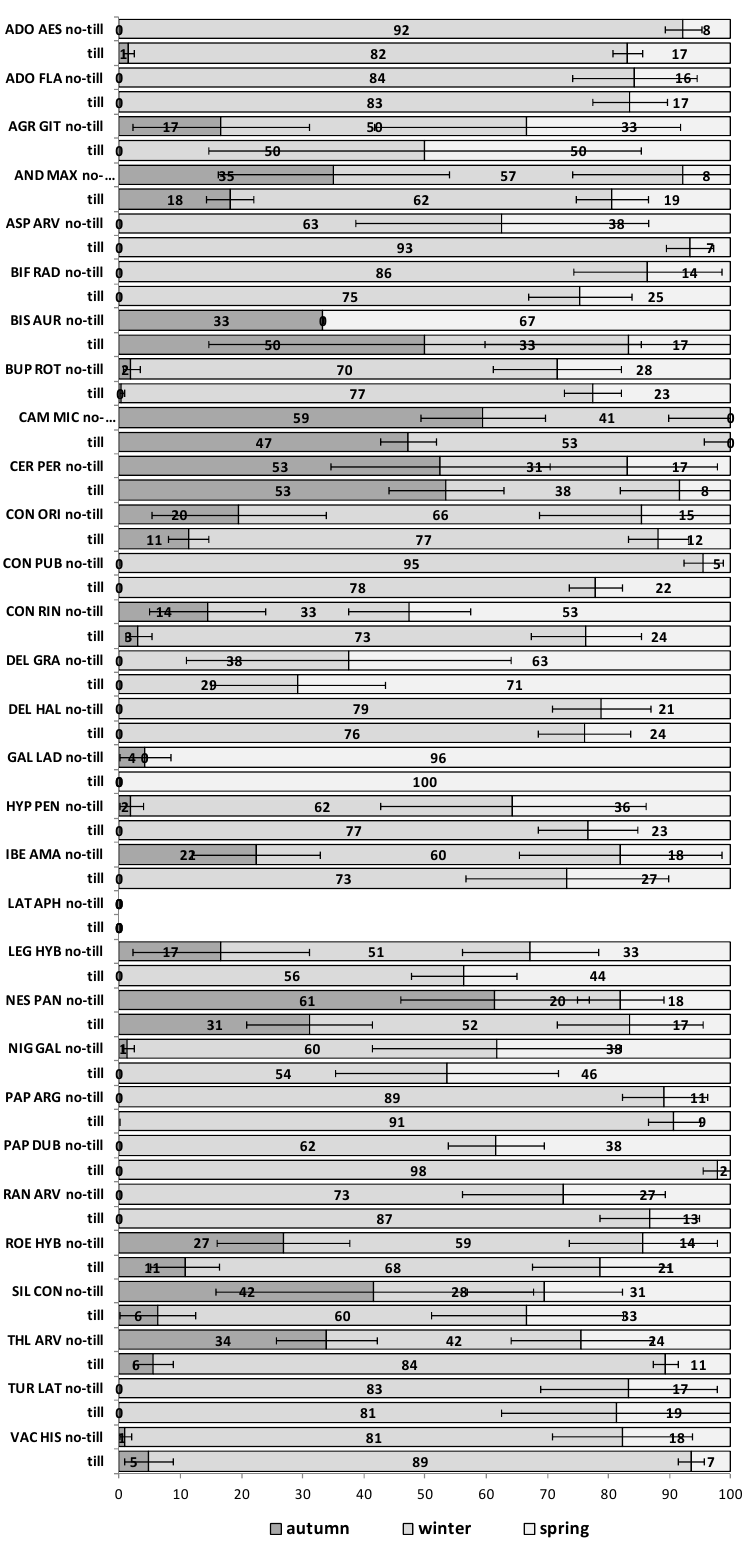
Figure A2. Relative Emergence patterns of 30 RAPs in autumn, winter, and spring during the second season (2013 / 2014) for seeds sown in 2012 (S1) in an arable field trial in Spain. Bars represent standard error. Two burial conditions are shown: 1 cm burial depth without soil disturbance (no-till) and 1–10 cm depth with annual autumnal soil disturbance (till).